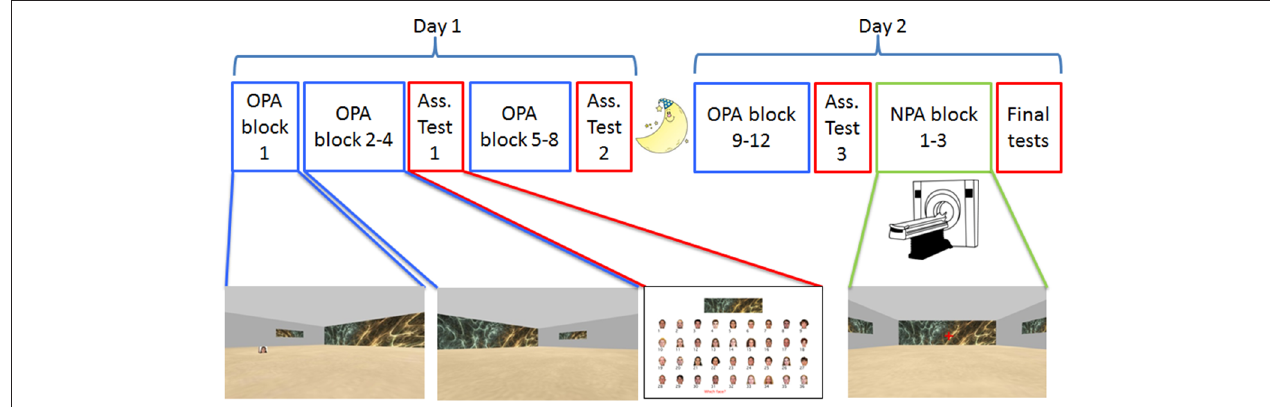
FIGURE 1 | Experimental design. Participants were tested on two consecutive days, approximately 24 h apart. The paradigm was a 2D navigational paradigm in which participants were instructed to learn face-cue locations (Old Paired Associates, OPA; in blue) in 36 rooms with differential wallpapers. On Day 1 and the beginning of Day 2, participants learned OPA-locations on a laptop computer. During OPA block 1 they saw the OPA-location and just had to move to it, but for OPA blocks 2–12 they had to search for the hidden OPA-location. After OPA blocks 4, 8 and 12, participants received an associative memory task in which they were asked to pair the right face with the correct environmental/room wallpaper (in red). After finishing OPA training, participants underwent fMRI while they learned a new (New Paired Associates, NPA; in green) location for each room, this time without a